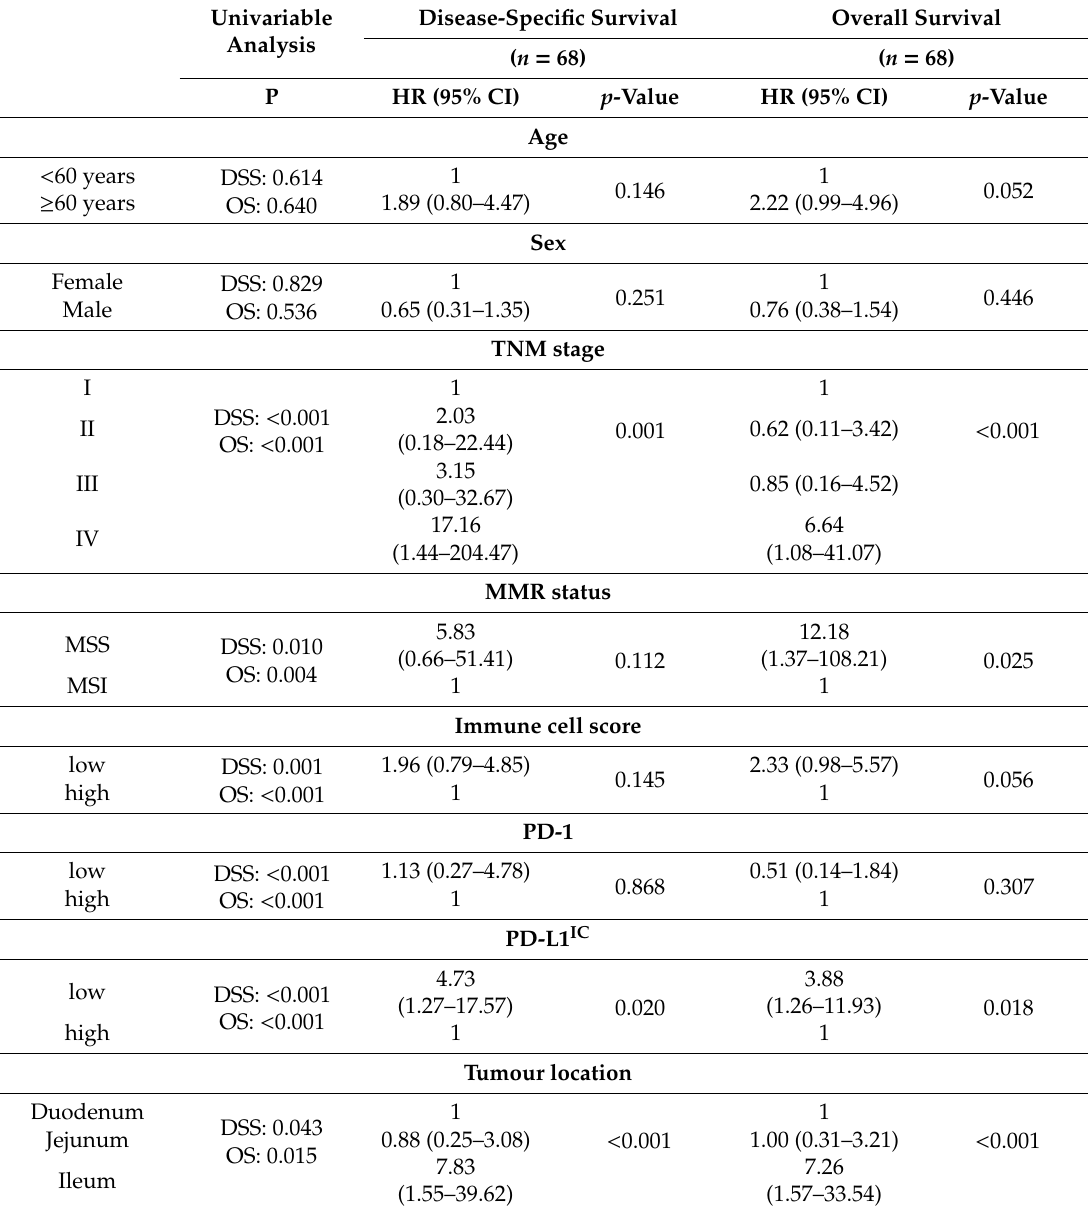
Table 4. Multivariable analysis with Immune cell score, PD-1 and PD-L1 IC